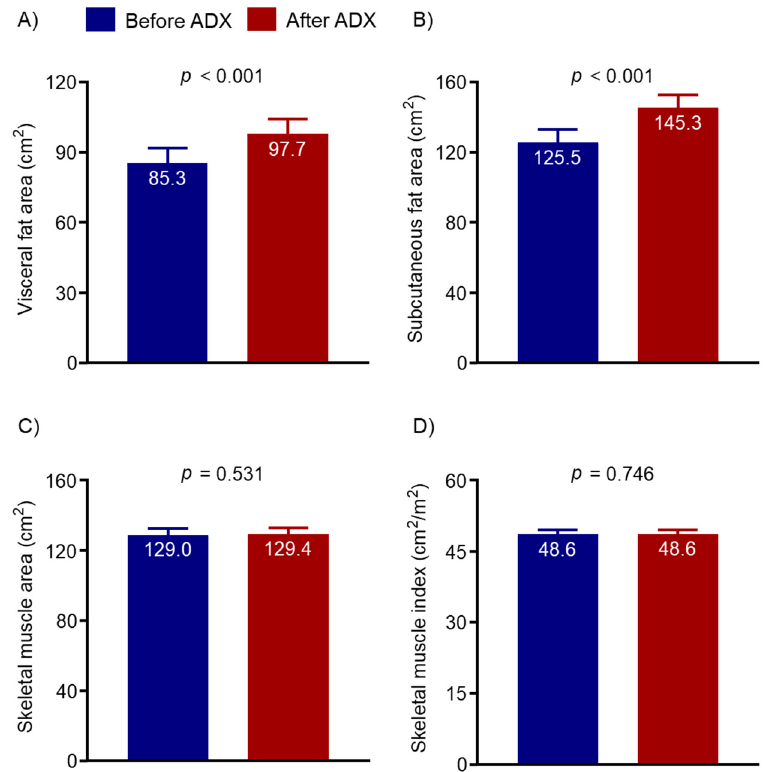
Figure 1. Changes in computed tomography-determined body compositions including visceral fat area ( A ), subcutaneous fat area ( B ), skeletal muscle area ( C ), and skeletal muscle index ( D ), before and after adrenalectomy in patients with pheochromocytoma. All p -values were calculated using the paired t -test or Wilcoxon signed-rank test, as appropriate. ADX, adrenalectomy.